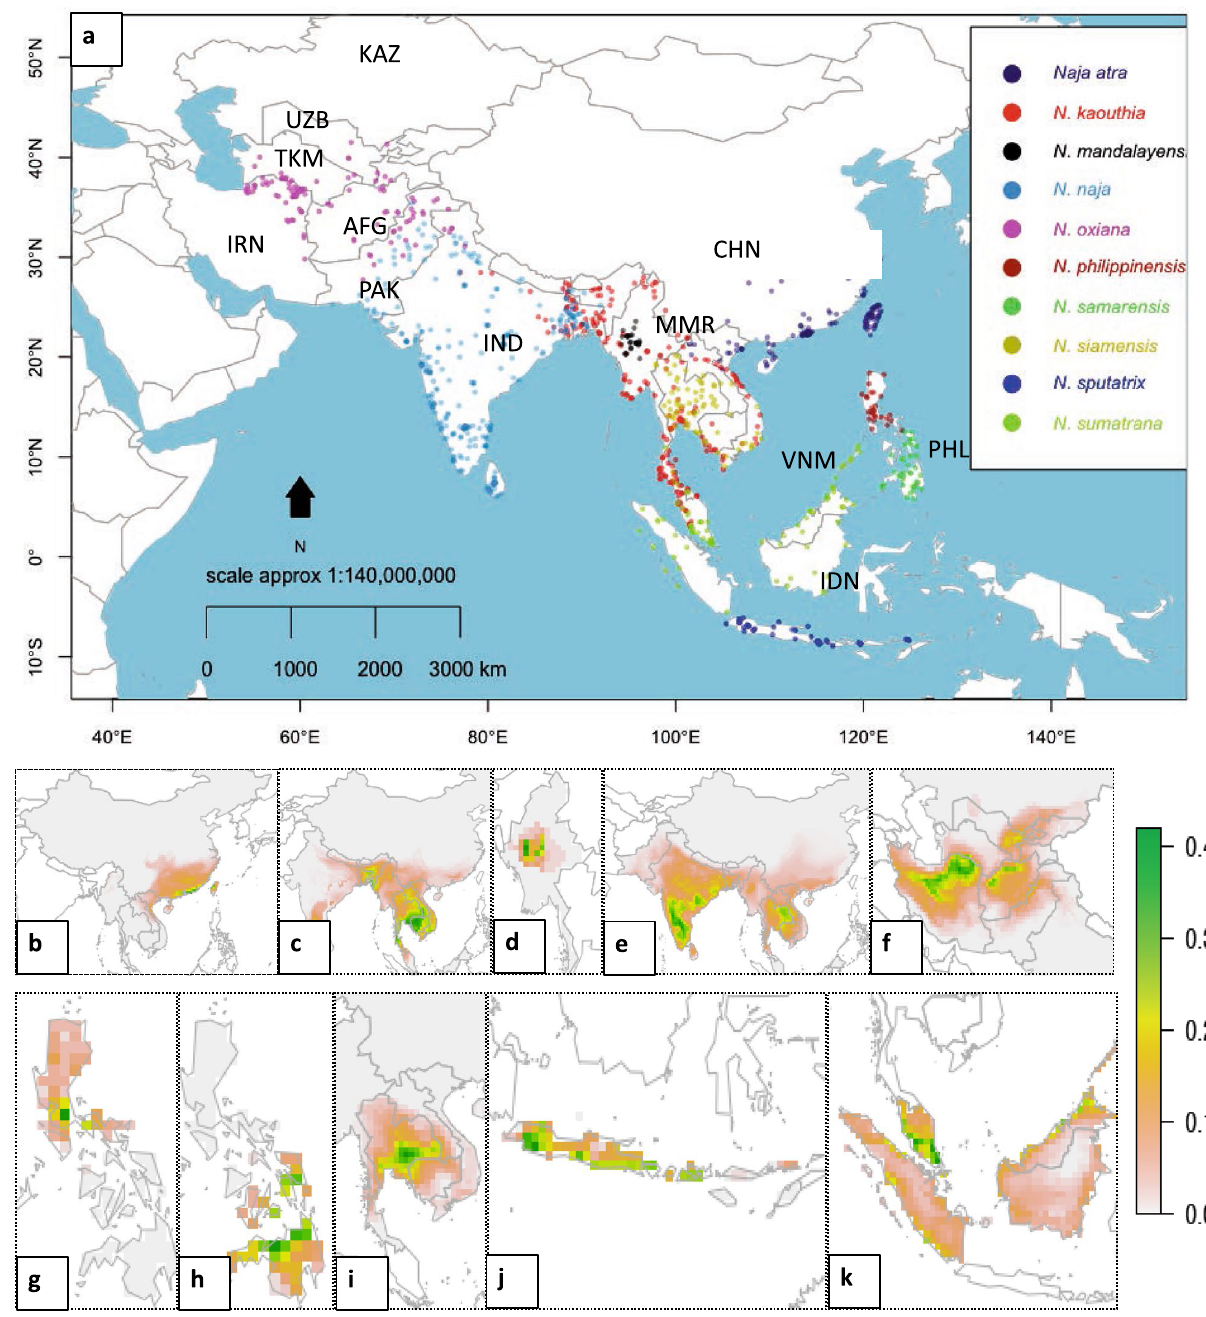
Figure 1. ( a ) The occurrence points of ten Asian cobras that are used in training the climate prediction model. The current potential climatic niche of ten Asiatic cobras that were produced by consensus of CCSM, CNRM, MIROC, and MIR global climate models ( b ) Naja atra , ( c ) N. kaouthia , ( d ) N. mandalayensis , ( e ) N. naja , ( f ) N. oxiana , (g) N. philippinensis, ( h ) N. samarensis , ( i ) N. siamensis , ( j ) N. sputatrix , and ( k ) N. sumatrana . The maps were generated from spatial polygon data frame of wrld_simpl function of maptools 64 mainly define cobra niches on the tropical islands (Fig. 5d–f), as islands receive a greater amount of precipita- tion annually (> 2000 mm) and during the driest quarter (> 300 mm) of the year, which is usually winter, than in other parts of the study area (Fig. 5c,e). Mandalay is a dry environment in Myanmar and hosts an endemic cobra, Naja mandalayensis , which has an extremely restricted distribution 32 . The habitats of this species also receive more rain (> 1000 mm) than those of the other cobra species adapted to the dry environments of central Asia, N. oxiana (< 400 mm).